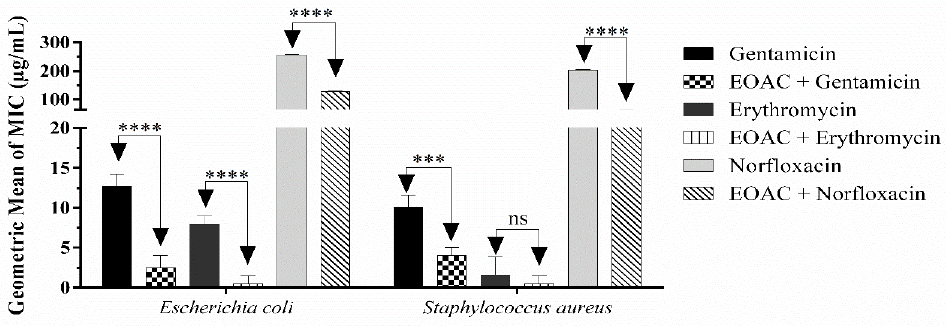
Figure 7. Modifying effect of Acritopappus confertus essential oil (EOAC) against the multidrug-resistant strains Staphylococcus aureus 10 and Escherichia coli 06, in association with the antibiotics gentamicin, erythromycin, and norfloxacin in µ g/mL. Statistically significant value with *** p > 0.001 and **** p < 0.0001.